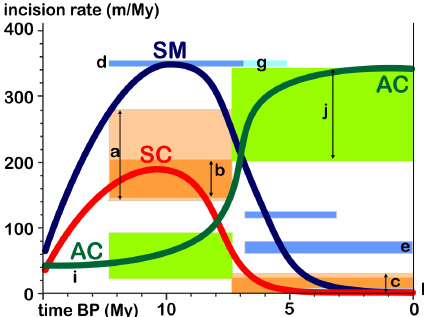
Figure 9. Evolution of incision rates in the studied ranges. Let- ters a–j correspond to river incision rates inferred from 40 Ar / 39 Ar dating (see text). Double-arrowed black lines show the range of cal- culated value for each of incision rate. Rectangles show the range of calculated values and time span of each of incision rate. Curves show the overall evolution of incision rates within each range, in- ferred from these discrete estimates. Blue shows Sierra de las Minas (SM), red shows Sierra de Chuacús (SC), and green shows Altos de Cuchumatanes